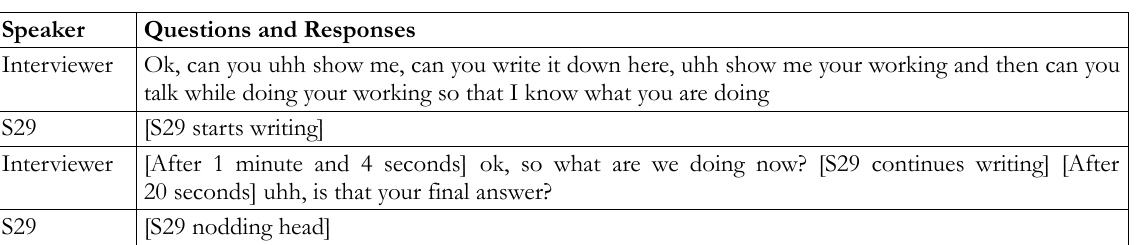
Table 7. Interview excerpts from student